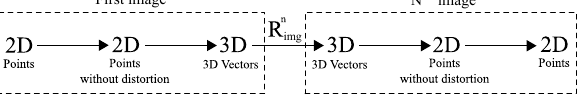
Figure 8. Successive steps to obtain the coordinates of corre- sponding location of pixel in other image. R n 3D rotation between the first image and the N th image.